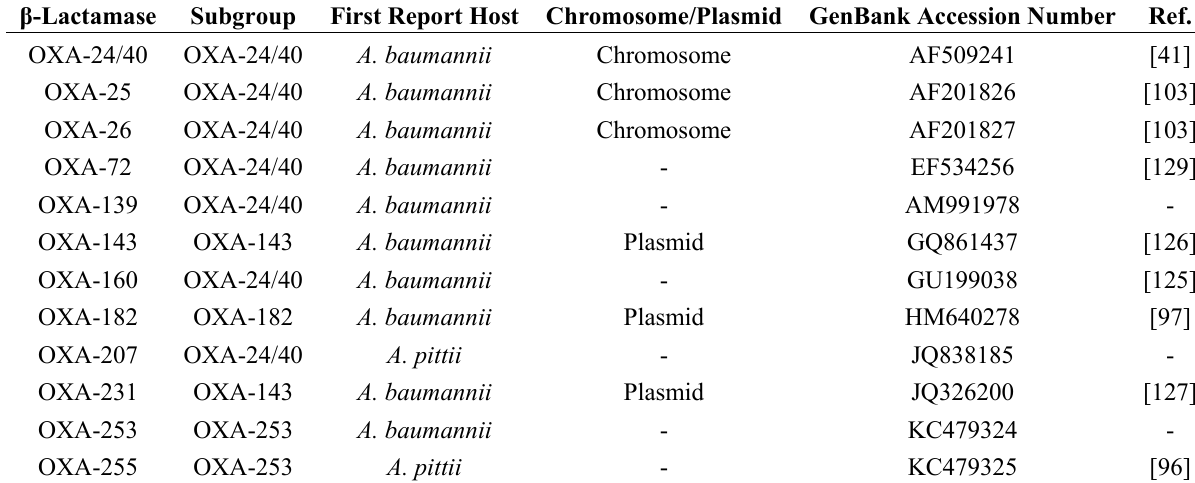
Table 11. OXA-24/40 like